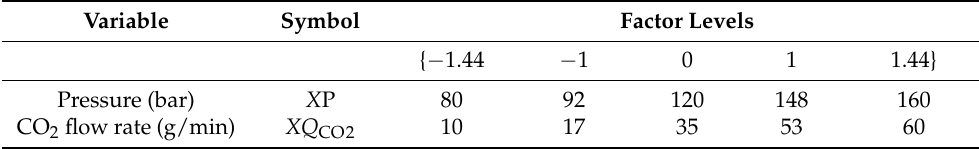
Table 1. Codification and levels of the two independent variables considered in the factorial design of SAF